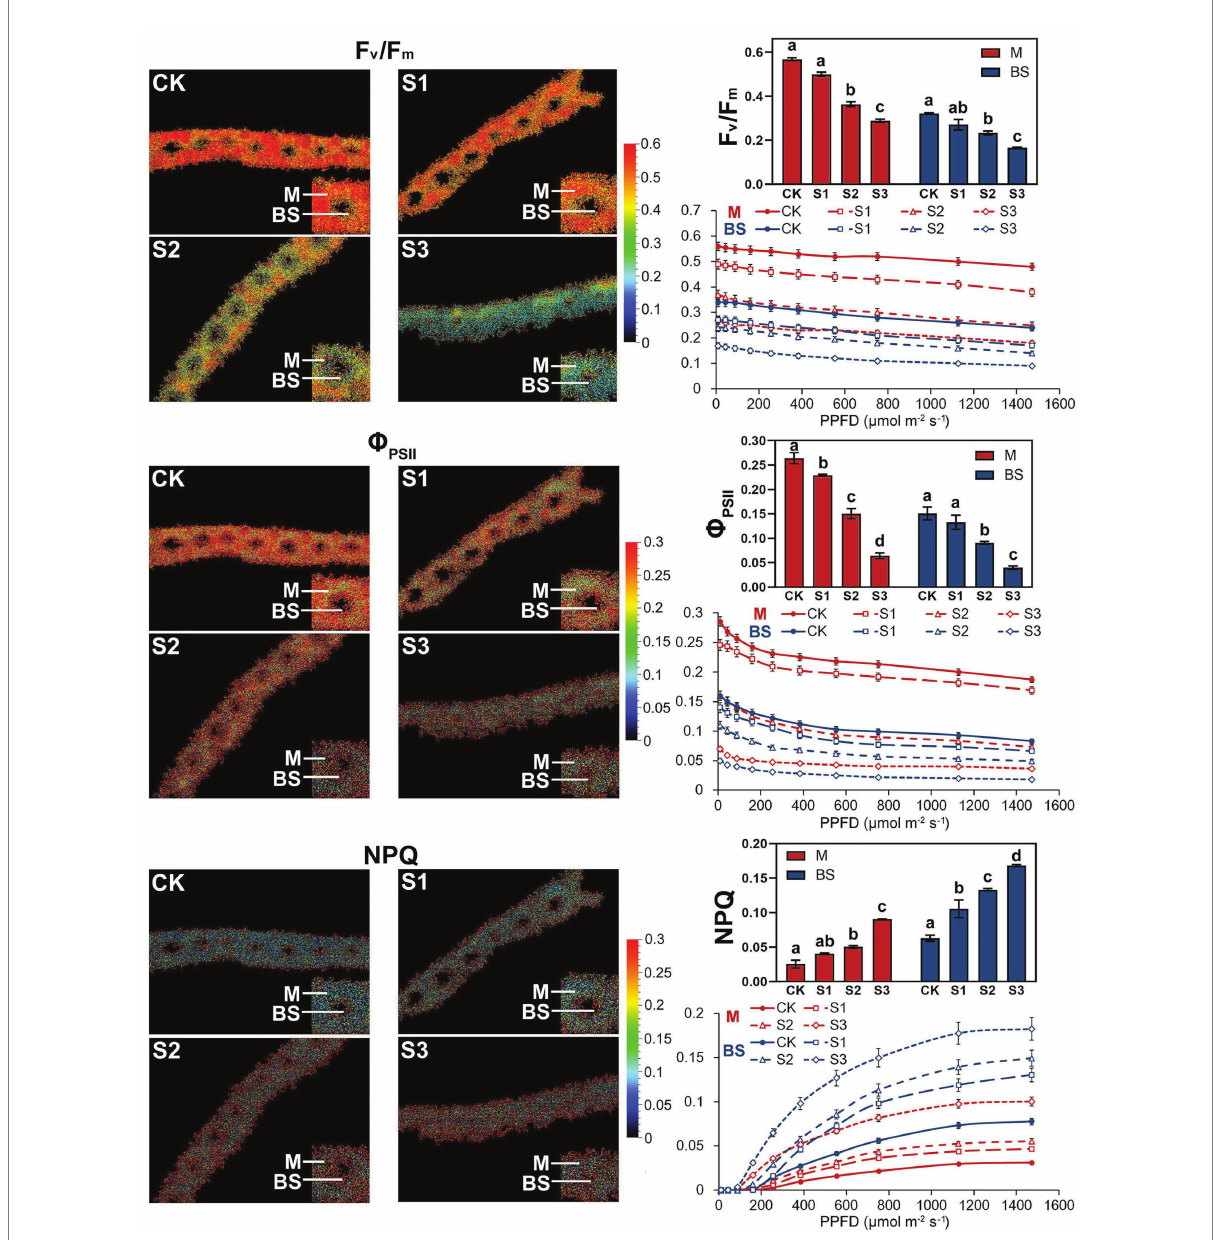
FIGURE 3 Chlorophyll fluorescence imaging and LRCs in M and BS chloroplasts of maize leaves under drought stress. Fv/Fm, the maximal photochemical quantum yield of PSII in darkness; Fv’/Fm’, the maximal photochemical quantum yield of PSII under light; Φ PSII , the effective photochemical quantum yield of PSII under light; NPQ, the non-photochemical fluorescence quenching under light. CK, well-watered control; S1, mild drought stress; S2, moderate drought stress; and S3, severe drought stress. Vertical bars represent SD of the mean ( n = 4). Different letters mean significant differences at the 0.05 level according to Duncan’s multiplication range